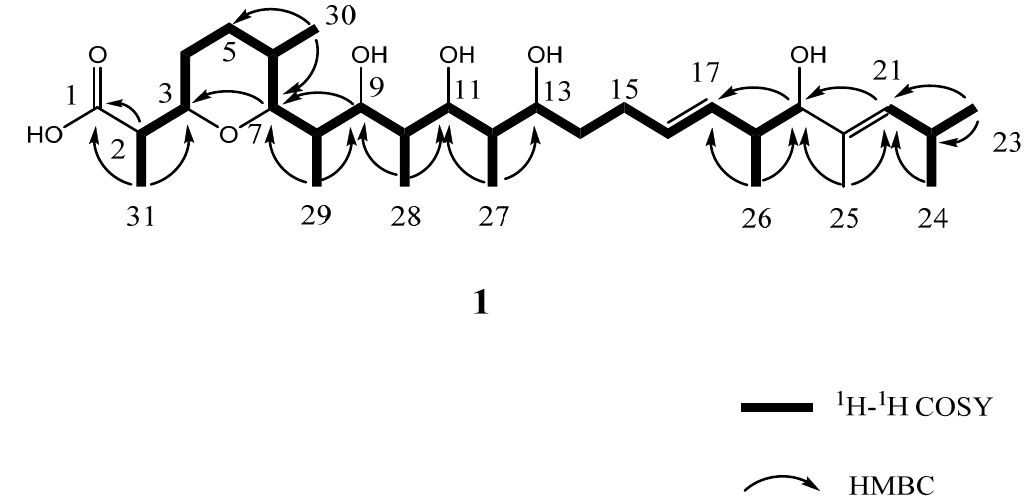
Figure 5. The structures of compounds 1 – 8. Compound 1 was isolated as white solid with [ α ] 25 D + 15 (c 0.043, EtOH) and UV (EtOH) λ max nm (log ε ): 202 (4.53). Its molecular formula was established as C 31 H 56 O 7 by HR-ESI-MS at m/z 539.3942 [M-H] - (calcd 539.3953 as C 31 H 55 O 7 ). The IR spectrum revealed hydroxyl absorption at 3320 cm − 1 and carbonyl absorption at 1735 cm − 1 , as well as methyl and methylene absorptions at 2953 cm − 1 and 2924 cm − 1 .